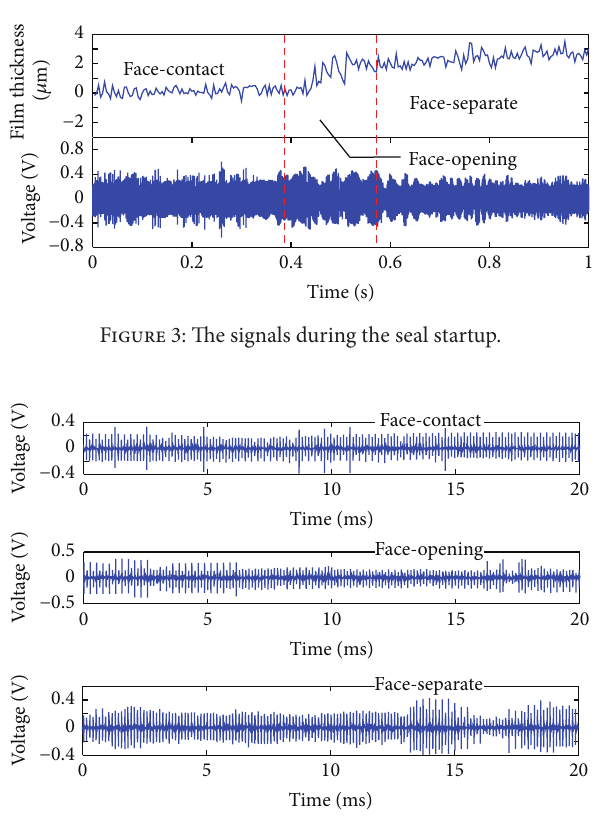
Figure 4: The AE signals in different contact states.